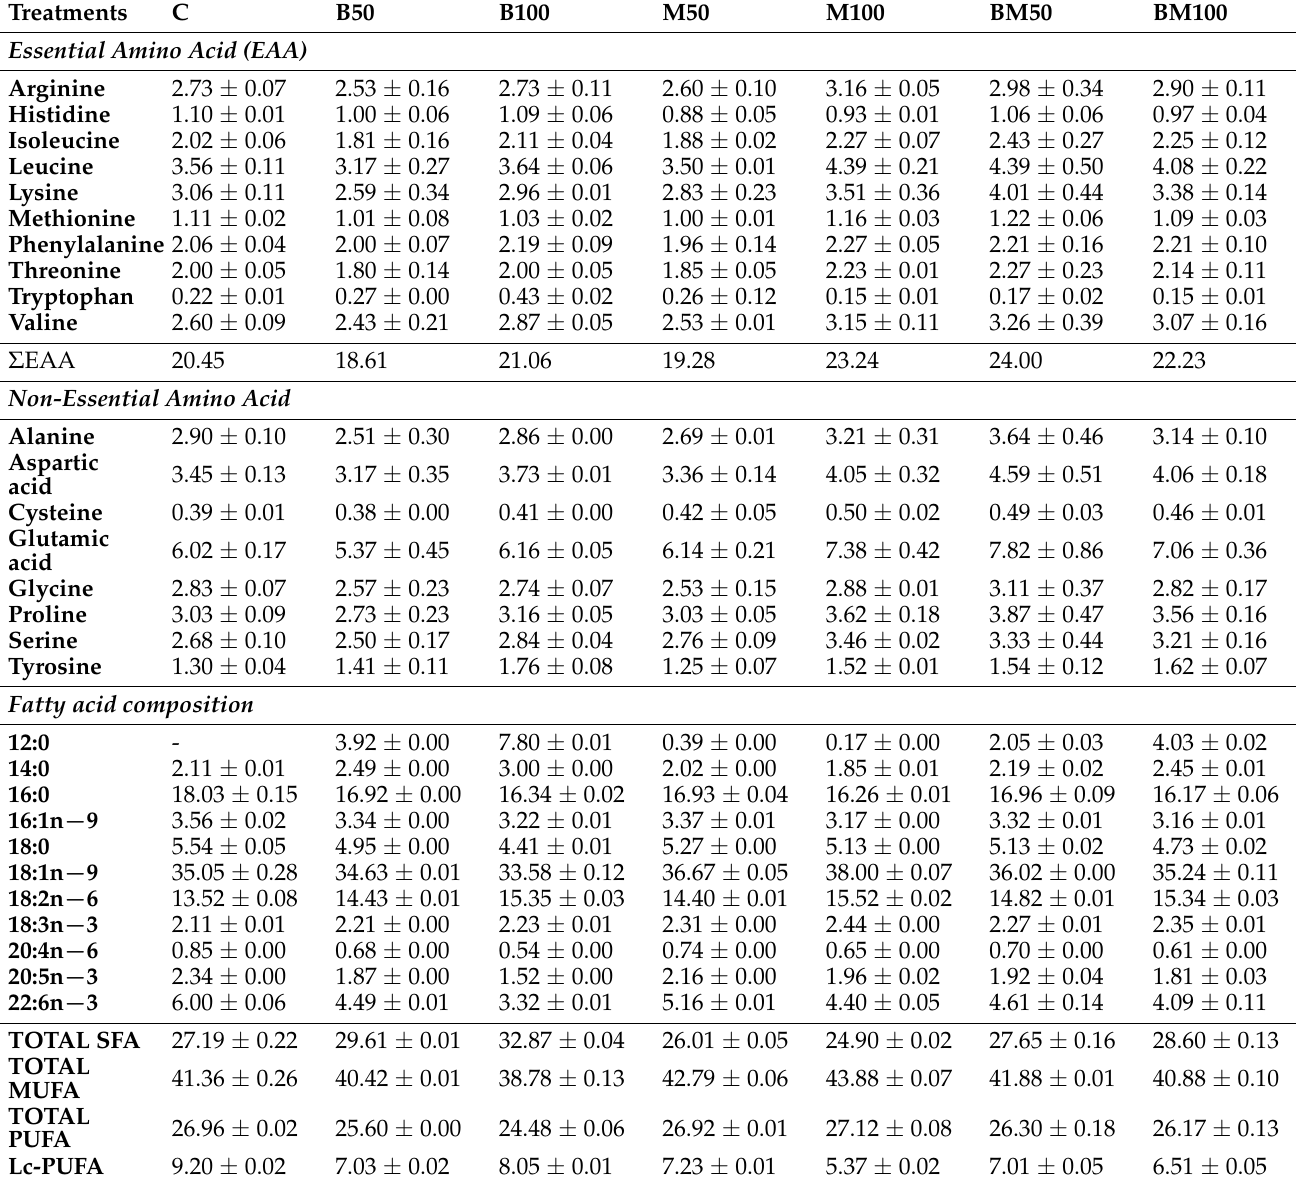
Table 3. Amino acid and fatty acid composition of the diets (% wet weight